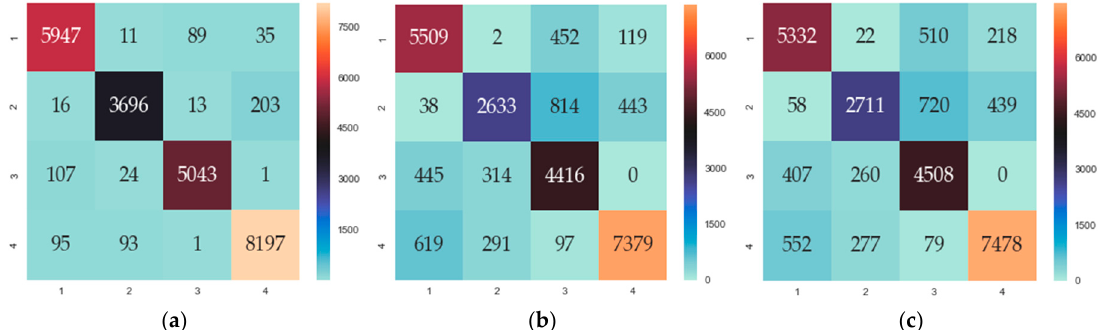
Figure 4. The confusion matrix of the three algorithms (1: single methane; 2: single ethylene; 3: air; 4: mixture). ( a ) The confusion matrix of the random forest (RF) classifier. ( b ) The confusion matrix of the logistic regression (LR) classifier. ( c ) The confusion matrix of the support vector machine (SVM) classifier.